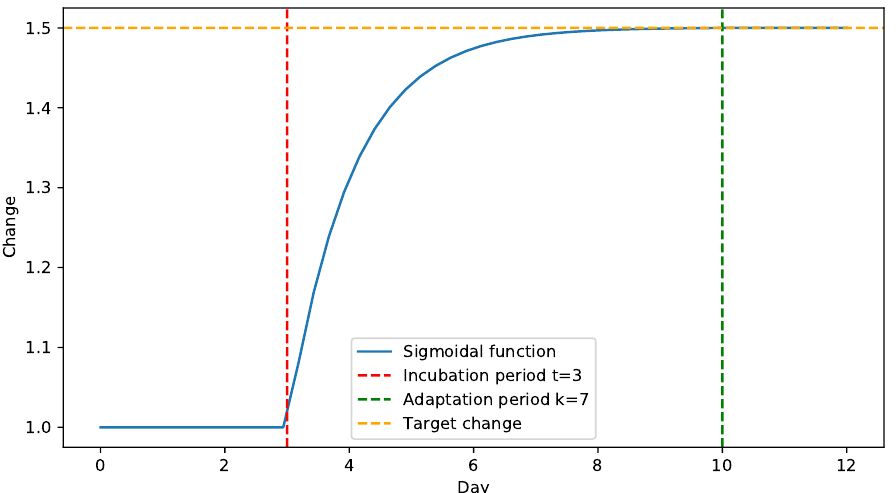
Figure 3. Representation of the sigmoidal function that has been used when applying a strong relaxation measure, assuming an incubation period t of 3 days and an adaptation period k to the new measure of 7 days. As a result, a smooth transition transition is obtained when a measure is considered in the expert